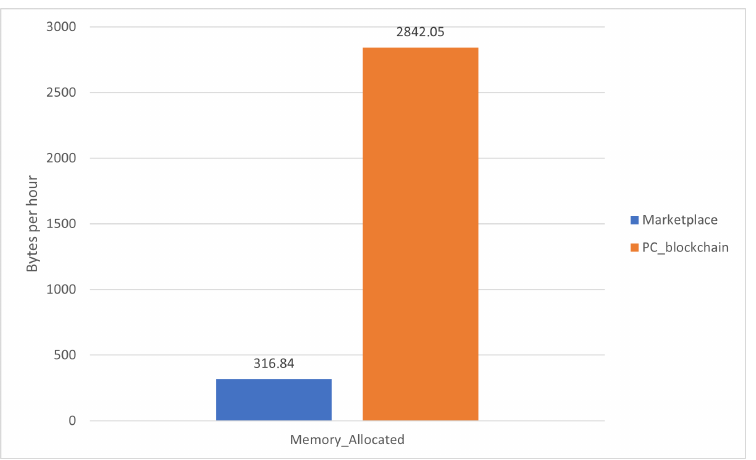
Figure 7. Comparison of the memory allocation metric between the proposed marketplace and an analogue blockchain over a